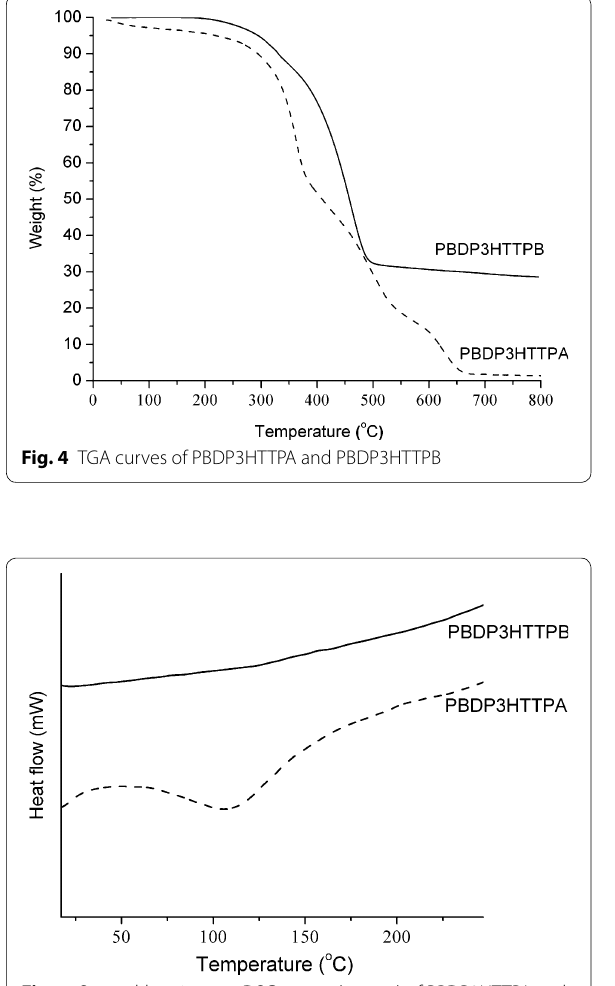
Fig. 5 Second‑heating run DSC curves (exo up) of PBDP3HTTPA and